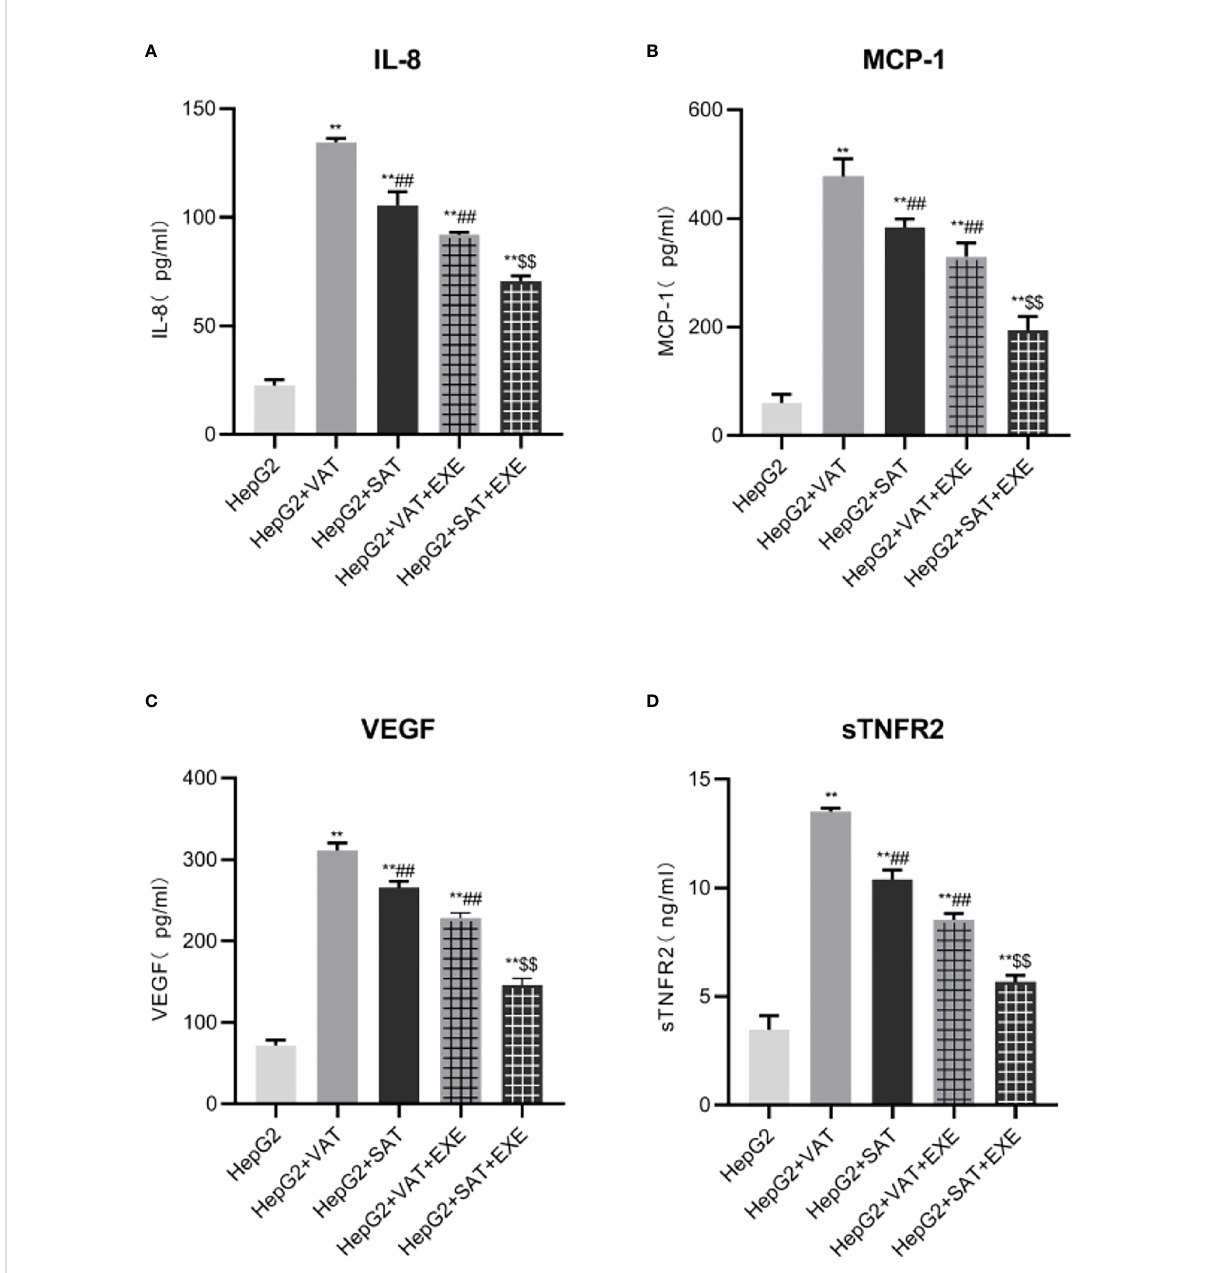
FIGURE 3 Exenatide inhibits adipokines secreted by adipose tissue at different sites. (A) The content of IL-8 in the supernatant of each group. (B) The content of MCP-1 in the supernatant of each group. (C) The content of VEGF in the supernatant of each group. (D) The content of sTNFR2 in the supernatant of each group. Data are means ± SEM, n = 3/group, **P < 0.01 vs. HepG2 group; ## P < 0.01 vs. HepG2+VAT group; $$ P < 0.01 vs. HepG2+SAT